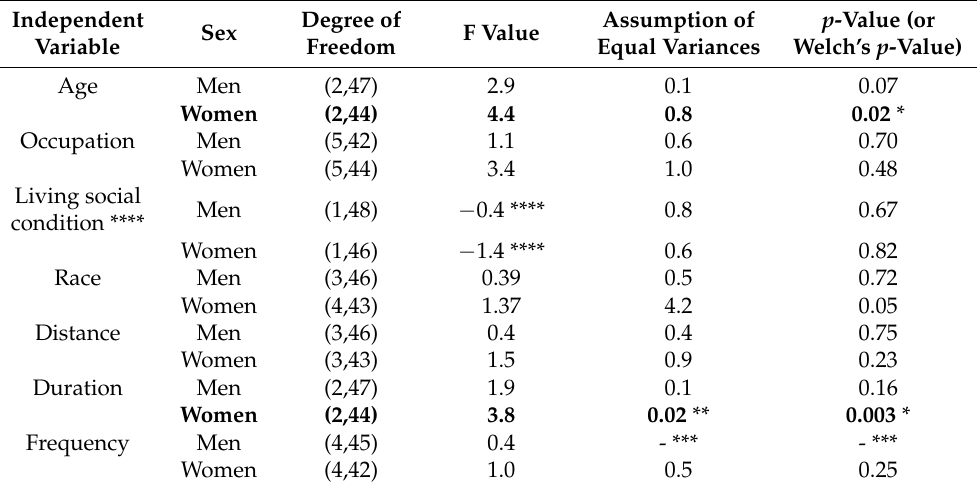
Table 3. ANOVA and Welch’s ANOVA for the relationships between age, distance, duration, and frequency and